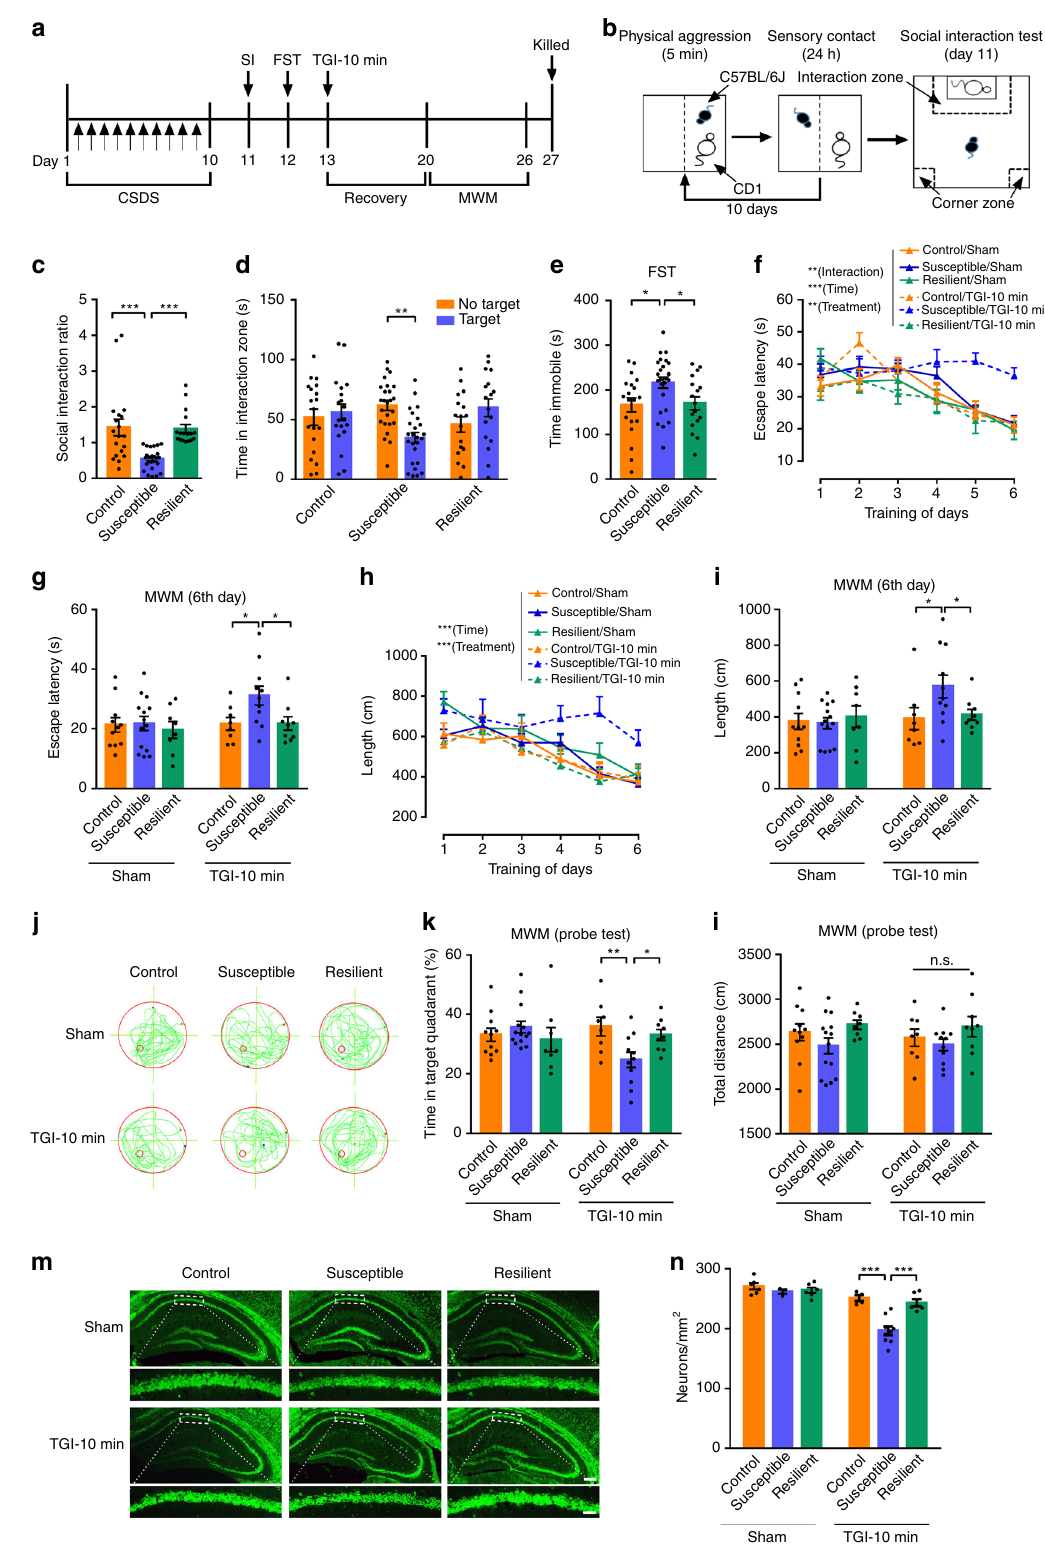
min, compared with sham mice (Fig. 1m, n). Taken together, the while TGI-10 min had no obvious damage to mice. Thus, we above experimental results show that TGI-20 min and TGI-30 chose TGI-10 min in the following experiments in order to min could cause the impairment of learning (at the later stage of observe the effects of depression on TGI-related learning and training session) and memory, and also loss of the CA1 neurons, memory impairment. NATURE COMMUNICATIONS| (2019) 10:2942